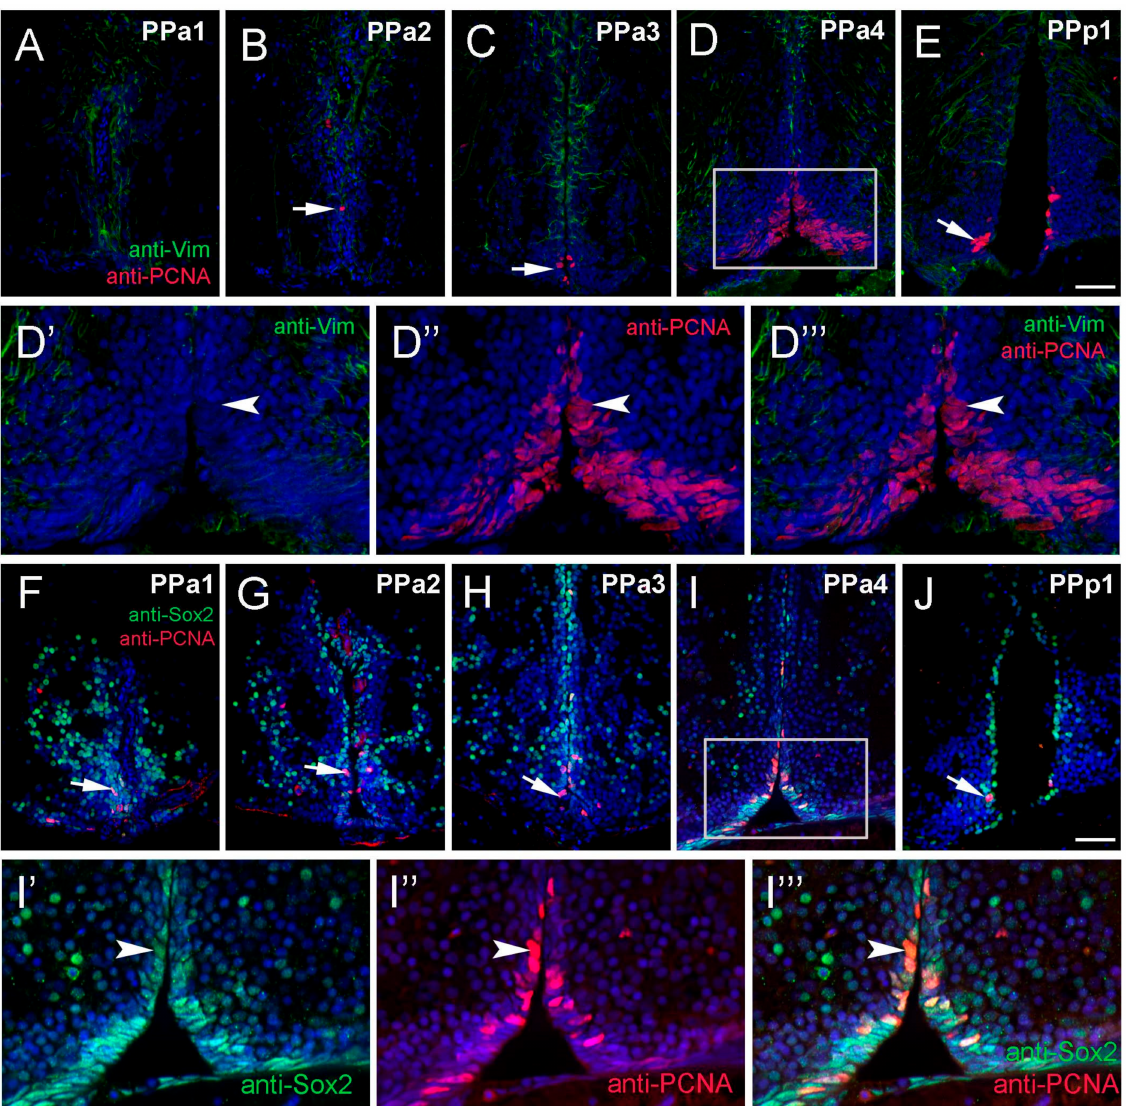
Figure 4. Proliferating cell nuclear antigen (PCNA) is located primarily in the PPa4/PPp1 transition region. ( A – J ) Transverse paraffin-sections of 5 µ m of POA. ( A – E ) Vim+ cells (green) are localized to the dorsal region of the POA, in contrast, PCNA+ cells (red, arrow ( B , C , E )) are found in the ventral of the POA. Vim+ labeling (( D’ , D”’ ), green) does not co-localize with anti-PCNA labeling (( D” , D”’ ), red). ( F – H ) Many Sox2+ cells (green) were observed in PPa1-3 and PPp1 ( J ) with few PCNA+ cells (red, arrows). ( I ) Sox2+ cells (green) and PCNA+ (red) in the ventral PPa4 region of the POA (boxed area) where the signals were co-localized in some cells (( I’ – I”’ ), arrowheads). All sections were labeled with DAPI (blue). Scale bar: 30 µ